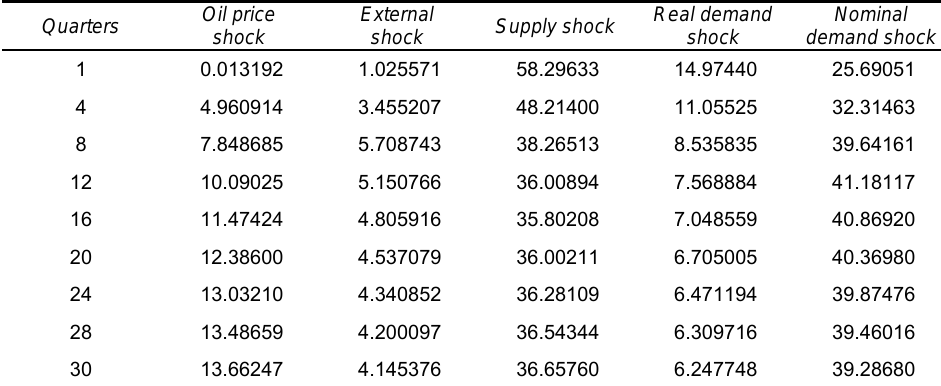
Table 5. Variance decomposition of the inflation rate Quarters